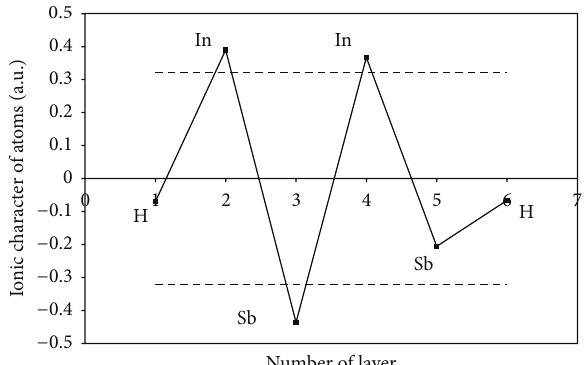
Figure 4: Atomic charges as a function of number of layers for InSb- hexamantane. PBE/3-21G is used for the calculations of this figure. Experimental values of bulk InSb charges are shown as broken lines [9].